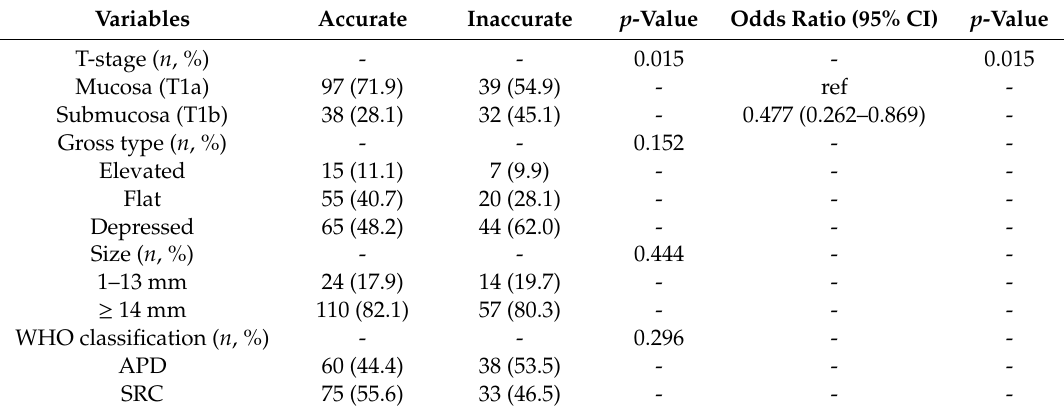
Table 4. Factors a ff ecting the accuracy of T-staging in undi ff erentiated-type adenocarcinoma. Variables Accurate